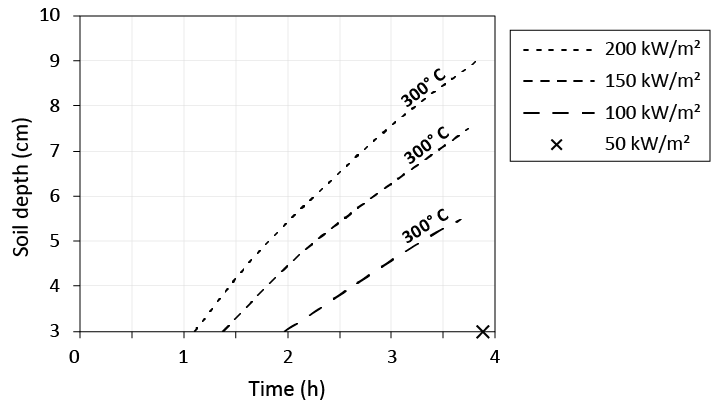
Figure 15. Assembly installed over a wooden deck with gypsum board. Relationship of time to failure of the deck (300 °C was reached under different thermal loads) and substrate thickness.